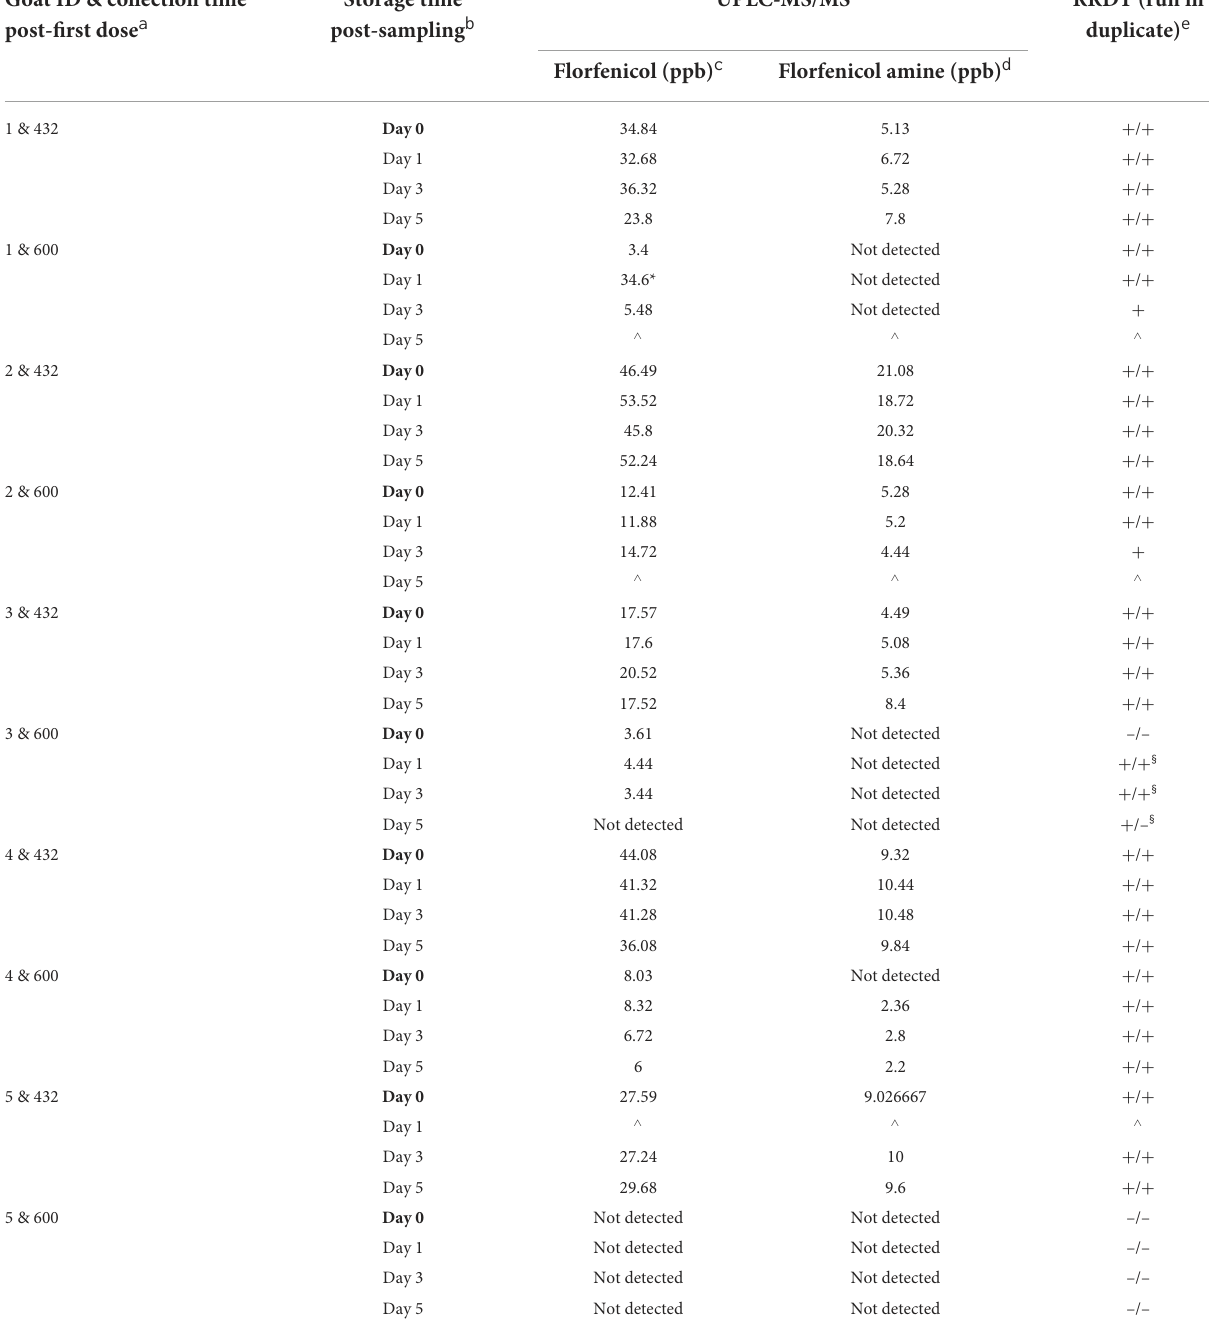
TABLE 5 Results for the effect of freezing samples at − 70 ◦ C for up to 5 days on florfenicol (ppb) and florfenicol amine (ppb) concentrations using ultra-performance liquid chromatography with tandem mass spectrometry (UPLC-MS/MS) and rapid residue detection test (RRDT) strips. Samples used on this trial were from animals in the study at specifics time